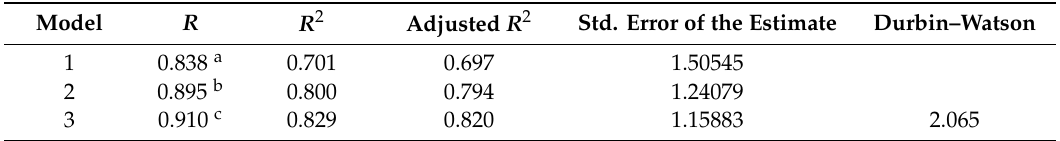
Table 6. Model summary utilizing the stepwise method.